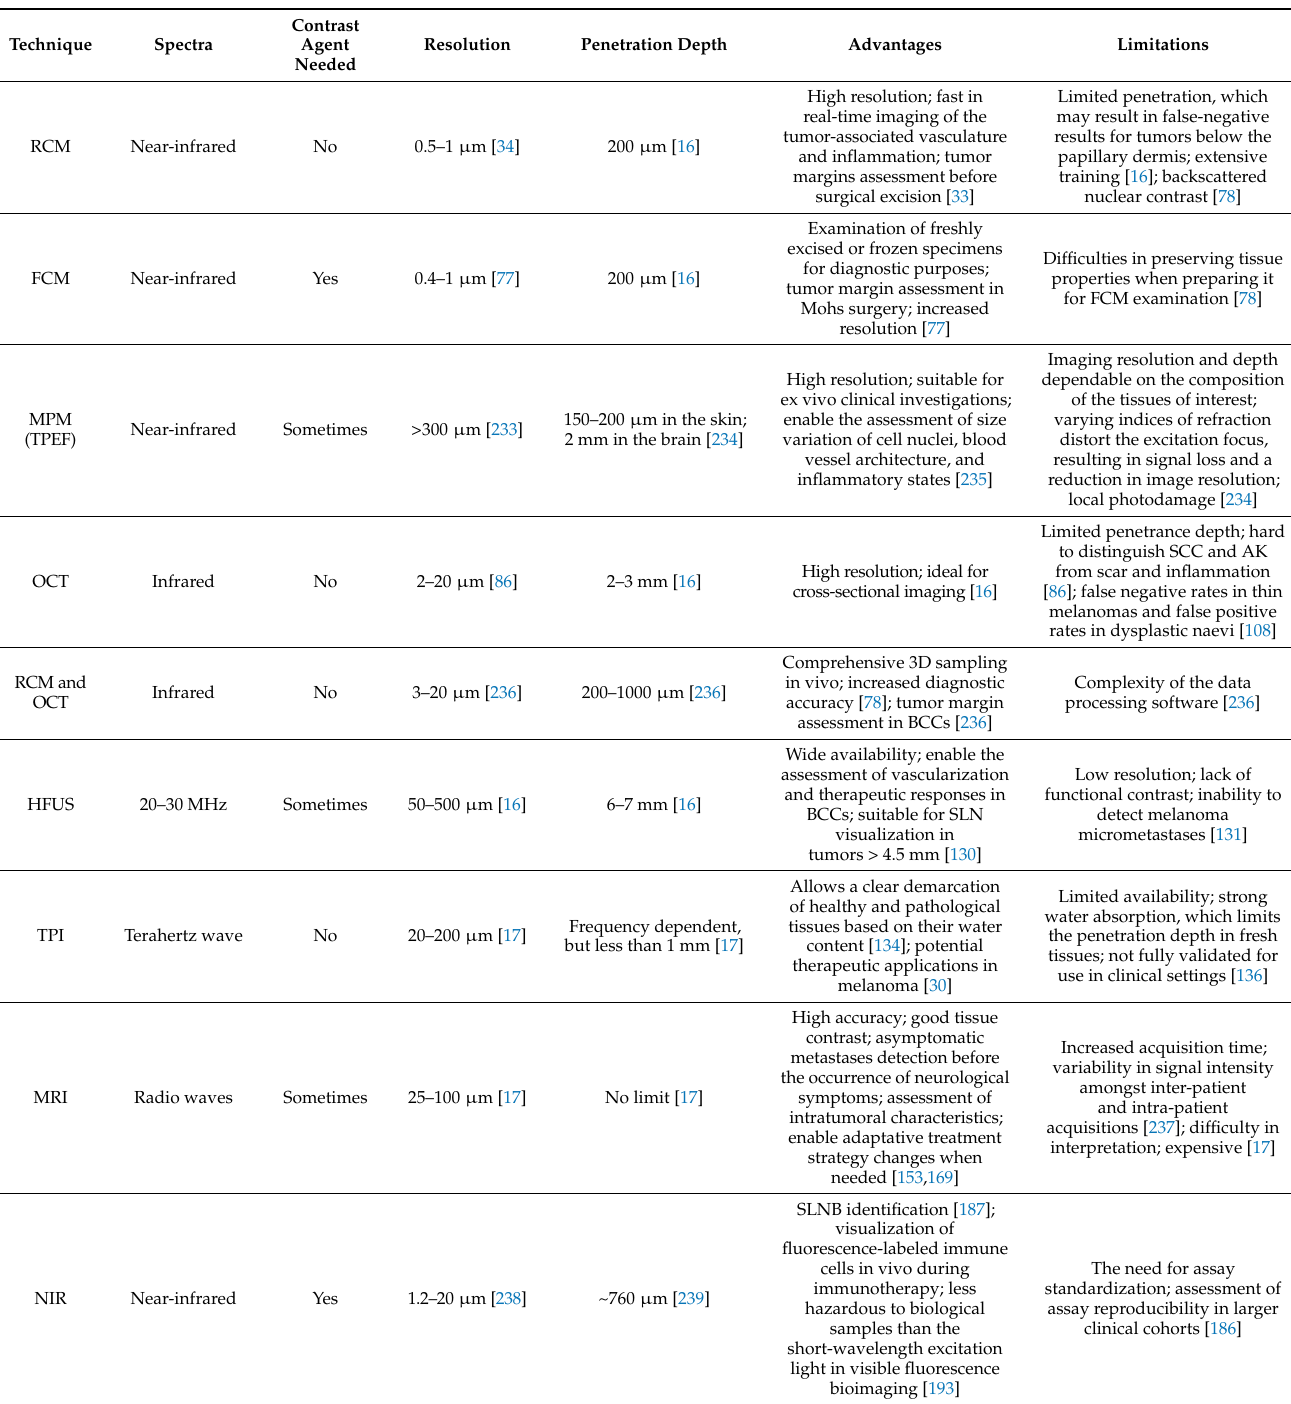
Table 1. Comparison of different imaging techniques available for skin cancer imaging 1